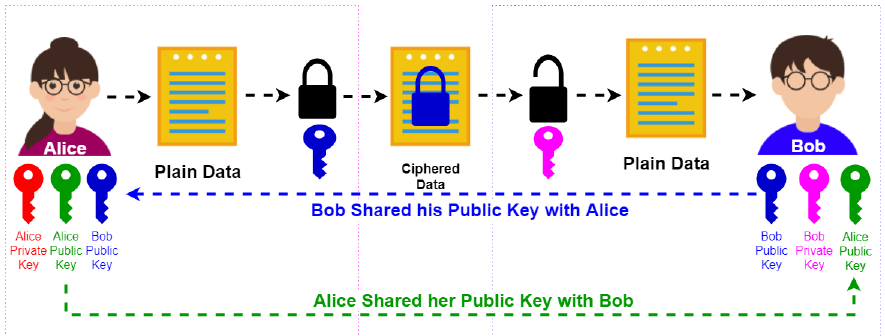
Figure 7. The Asymmetric Encryption